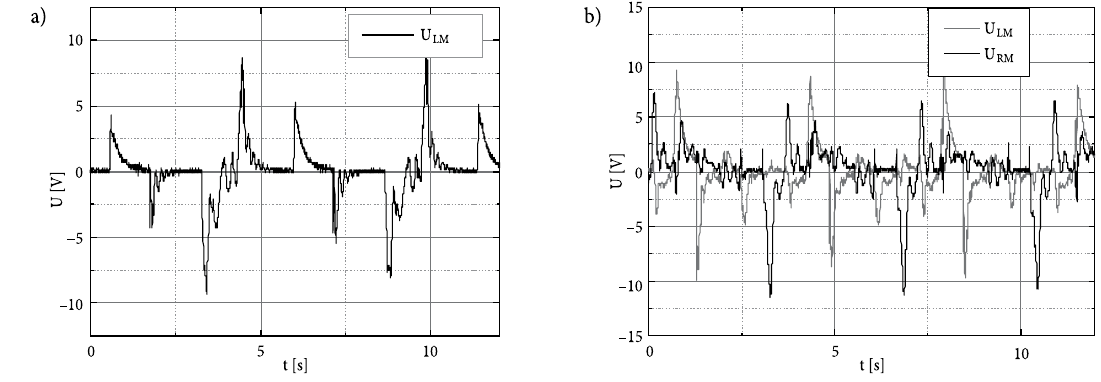
Fig. 6. Voltage time diagrams for: a – tripod gait; b – wave